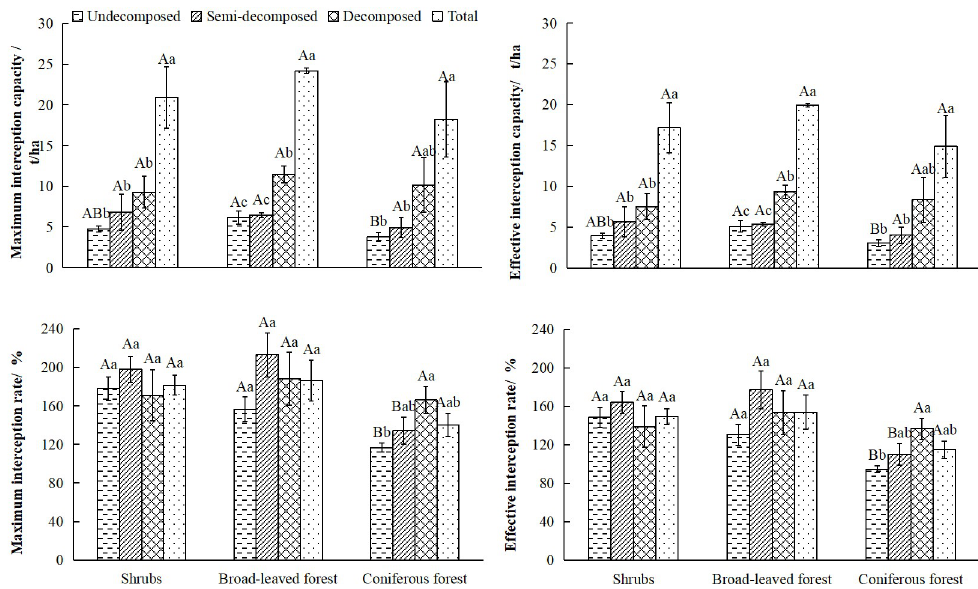
Fig 5. The hydrological characteristics of the litter in the three typical